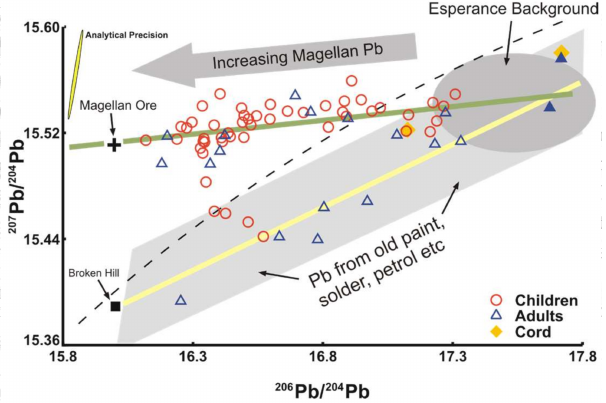
Figure 7. Conventional ( 204 Pb-based) isotope ratio plot for uranium-derived Pb isotopes. The dashed line is the Growth Curve or Pb Evolution Curve along which most massive sulfide deposits lie, such as Broken Hill. The green line is the line of best fit for the isotope data termed the “Magellan Array” and the yellow line the “Old Array”, described in the text. The hatched fields denoted by arrows are estimations of the possible isotopic fingerprints. The data represented by blue filled symbols with the highest 206 Pb/ 204 Pb values could lie on either array. The 95% confidence ellipse in the upper left-hand corner represents the measuring